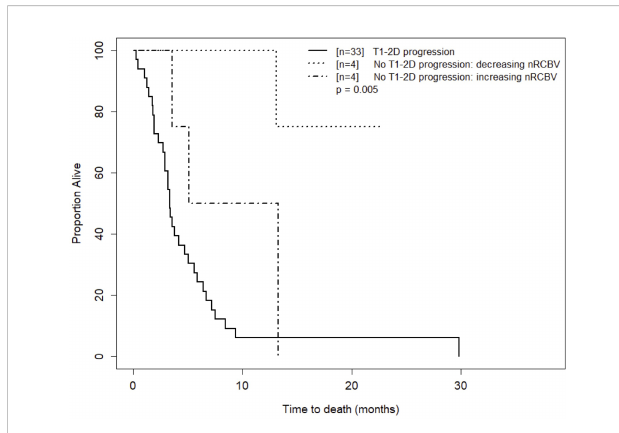
FIGURE 5 Kaplan-Meier curves for time to death for T1 progressors and T1 non- progressors with increasing versus decreasing nRCBV at week 16. Visual separation of the curves potentiates 3-tier survival strati fi cation, and an interpretation paradigm for recurrent GBM shortly after Bevacizumab whereby patients with progressive enhancement are deemed treatment failures, and change in rCBV further distinguishes relative successes from